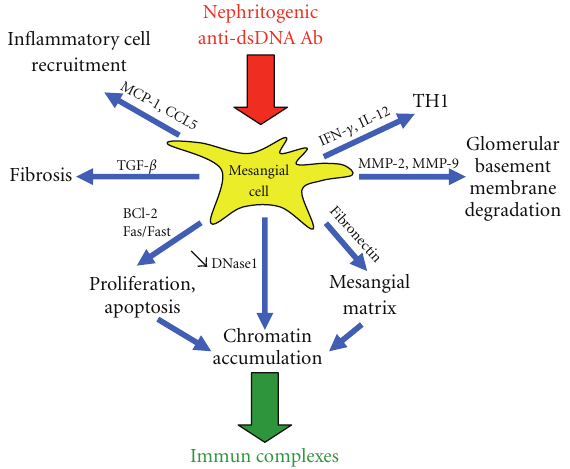
Figure 2: A working model of mesangial cell (MC) stimulation by nephritogenic anti-dsDNA Ab in lupus nephritis leading to accumulation of immune